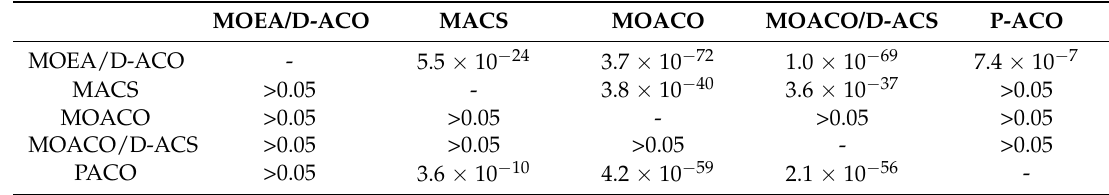
Table 5. Kruskal–Wallis test on kroAD100 based on